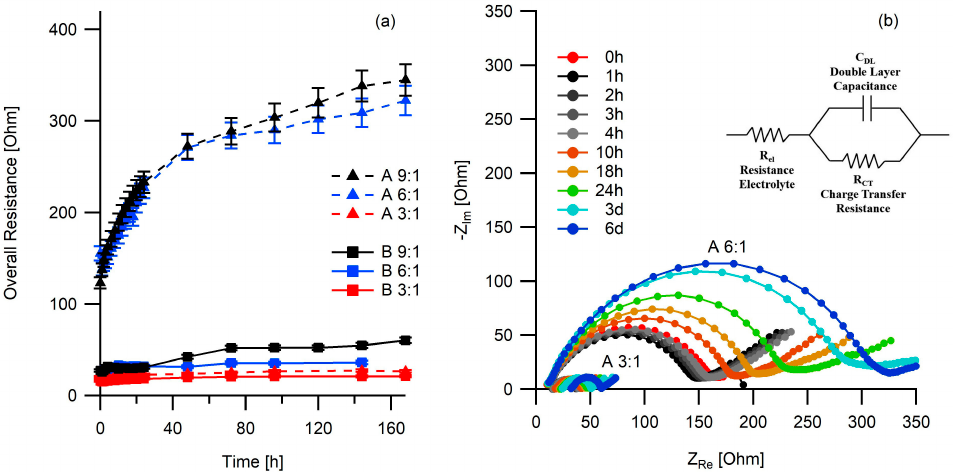
Figure 6. Evolution of the interfacial resistance for Li||Li symmetrical cells for all PIL el ( a ) and Nyquist plots for A 6:1 and 3:1 ( b ).